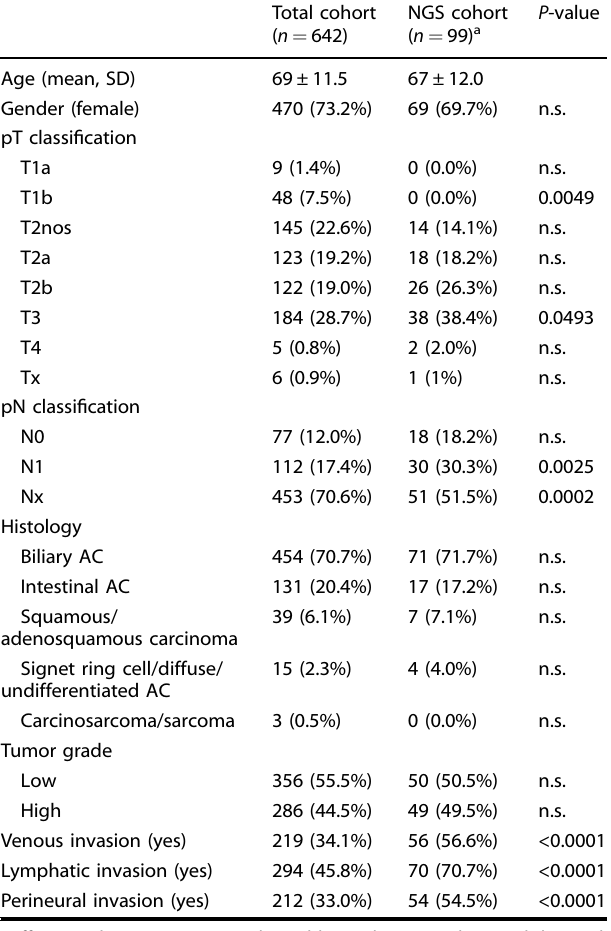
Table 1. Patient and tumor